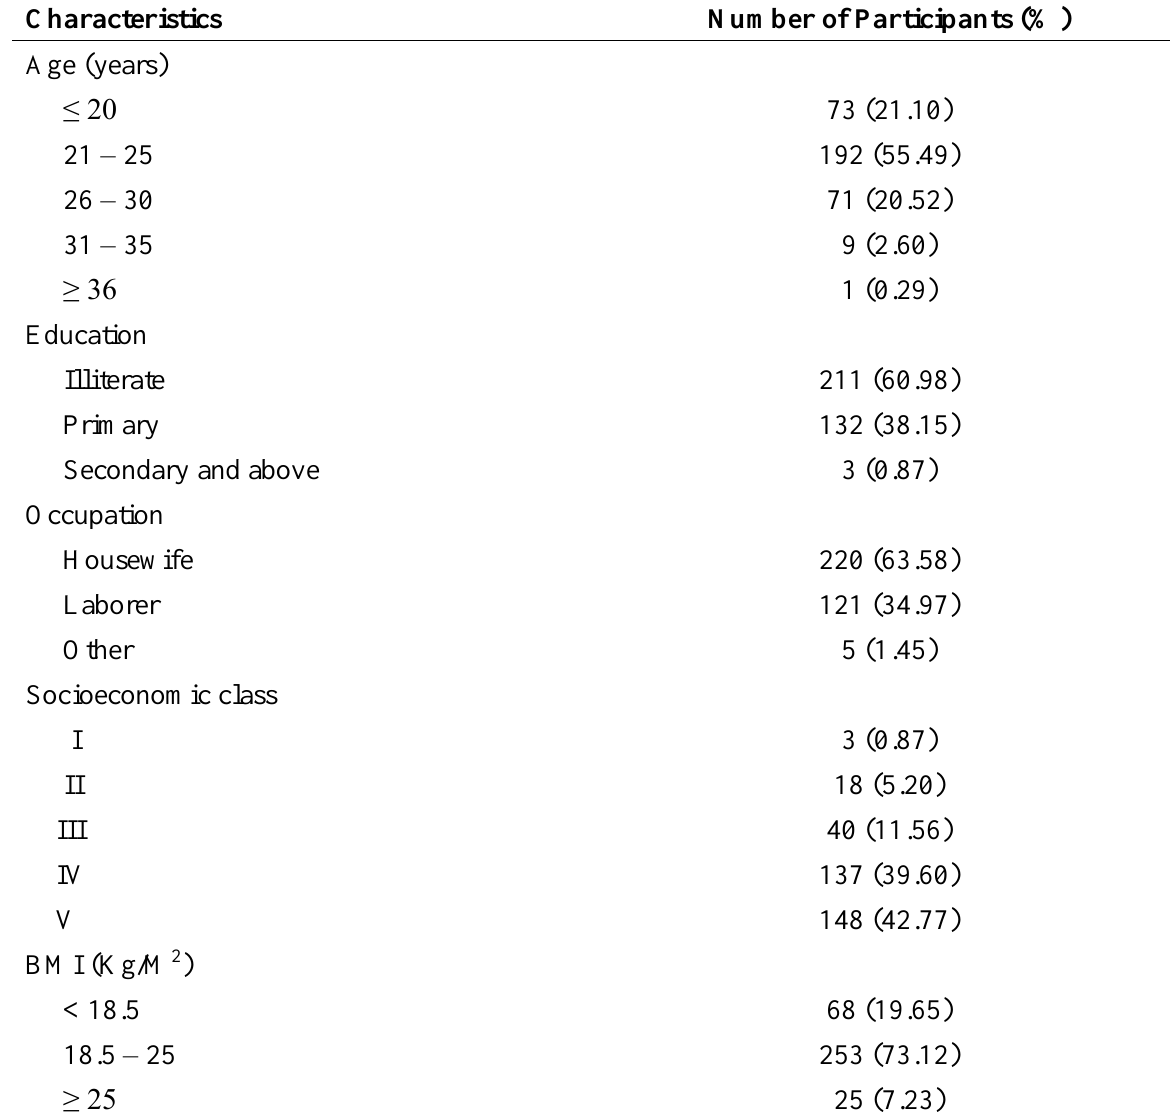
Table 1: Baseline characteristics of study participants from the Davas